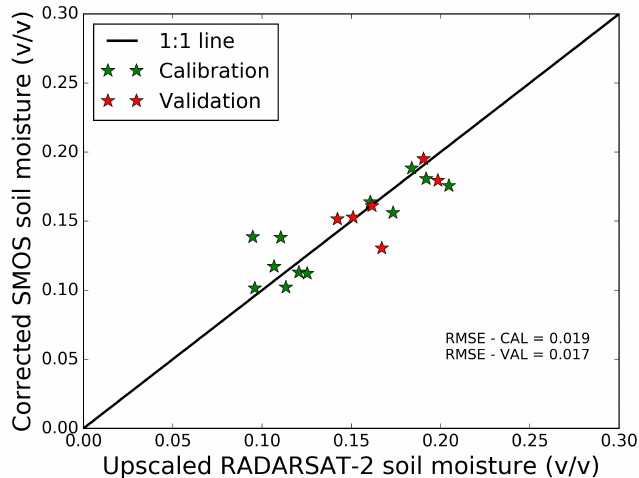
Figure 9. Comparison of the bias corrected SMOS soil moisture with upscaled RADARSAT-2 soil moisture for the calibration and validation